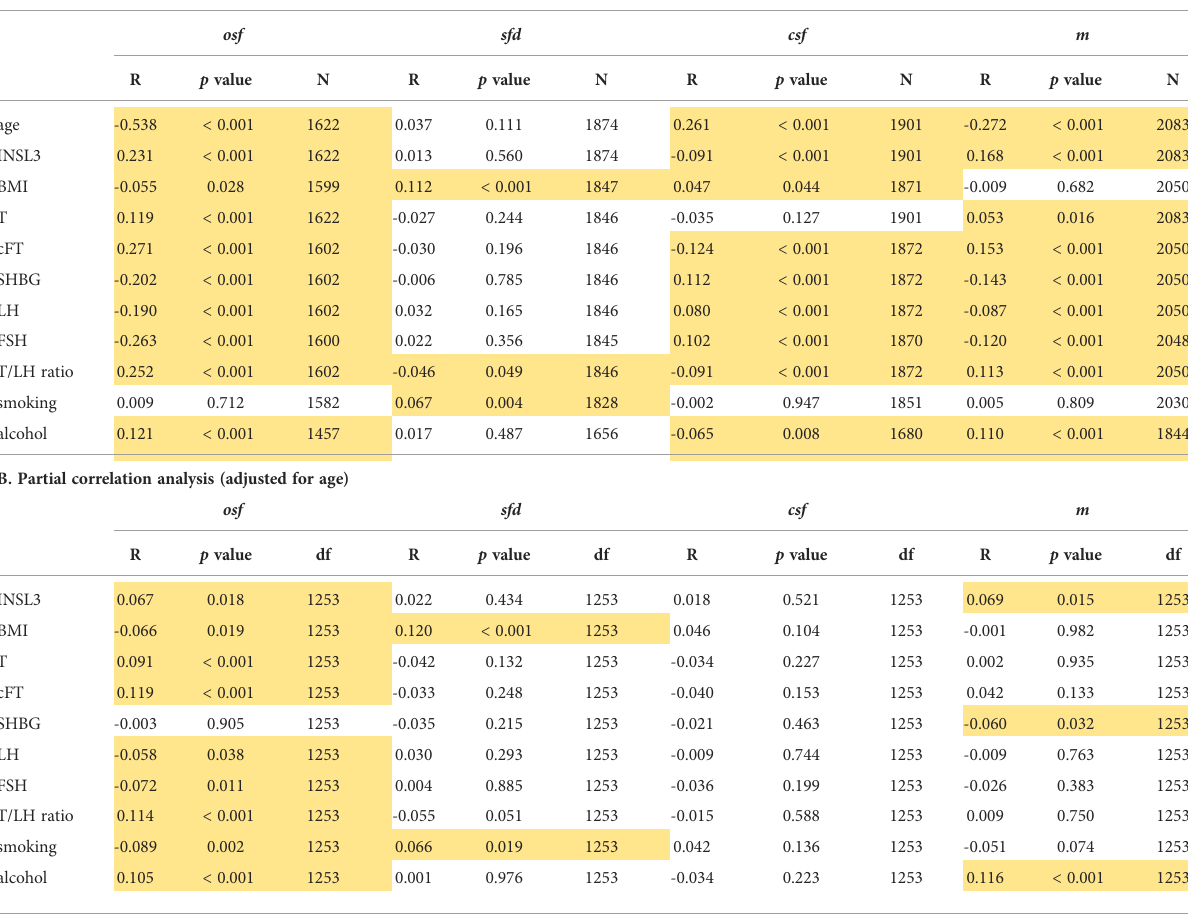
TABLE 2 (A) Unadjusted simple correlation analysis for the principal component parameters osf (overall sexual function), sfd (sexual function distress), csf (change in sexual function) and m (frequency of masturbation) against hormonal, anthropometric, and lifestyle parameters, as indicated (for details, see Materials and